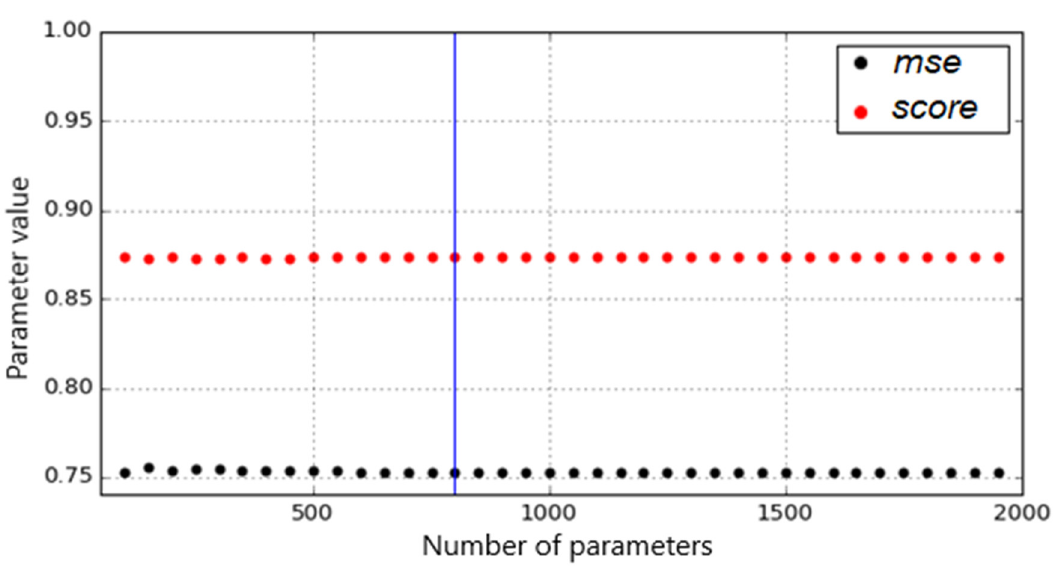
Figure 7. Determination of the n-estimators parameter using the random forest regressor method.